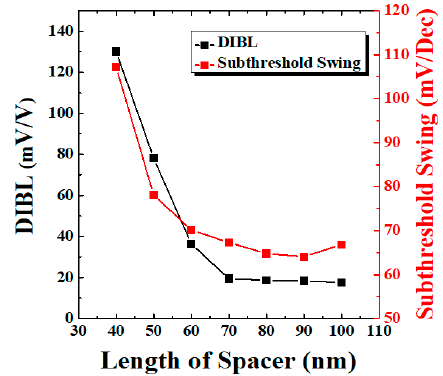
Figure 3. Drain-induced barrier lowering and sub-threshold slope characteristics comparison of N-type bulk FinFET according to spacer